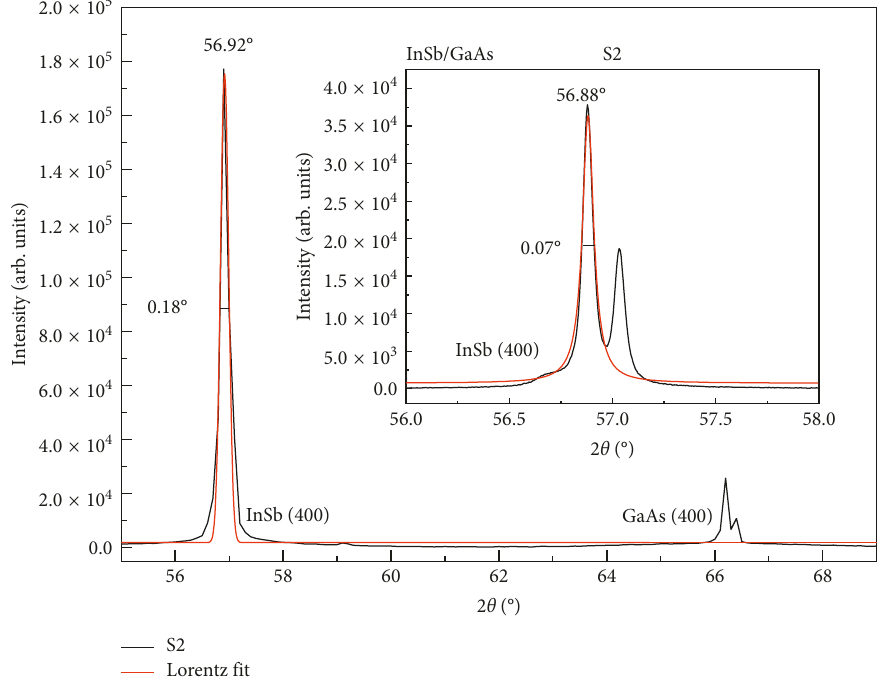
Figure 2: XRD spectrum and Lorentz fit of S2 in the angle range of 55 ° –69 °